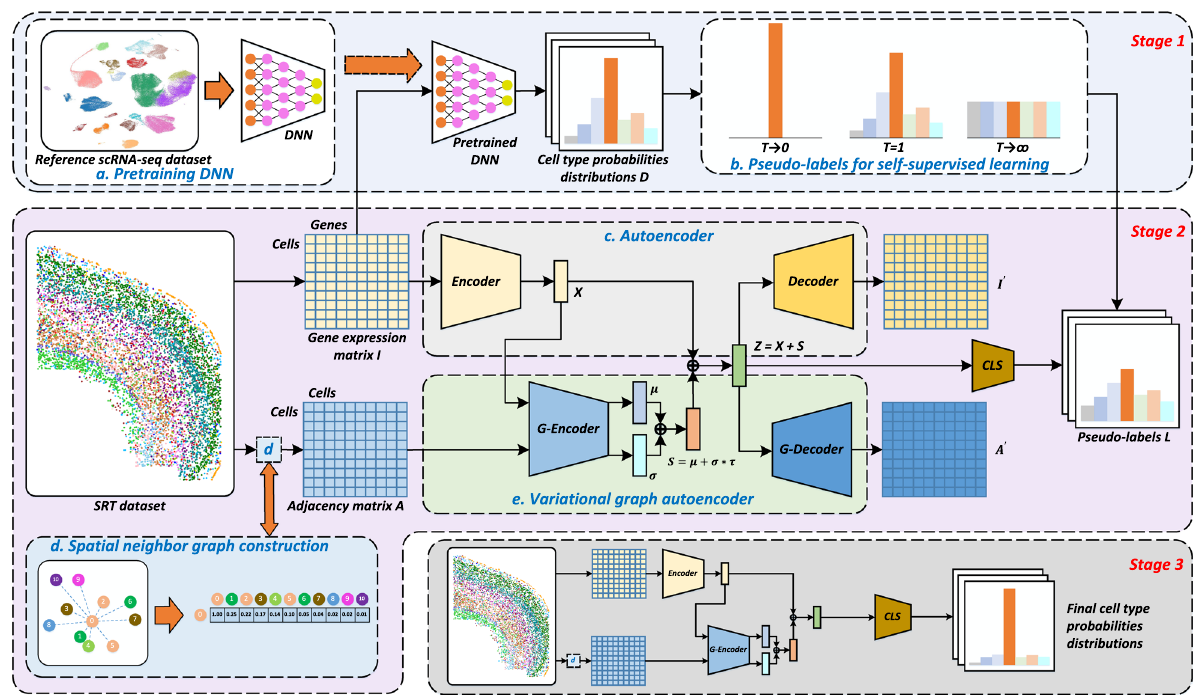
Fig.1|OverviewofSpatial-ID. Stage1involvesknowledgetransferfromreference datasets. Stage 2 involves feature embedding of gene expression and spatial information, and employs self-supervised strategy to train a classi fi er (CLS) using the generated pseudo-labels in stage 1. Stage 3 uses the optimal model derived from Stage 2 to perform cell type annotation. a Reference scRNA-seq datasets are employedto pretraindeep neural network (DNN)models. b Based onthe celltype probabilities distributions D produced by pretrained DNN, pseudo-labels L